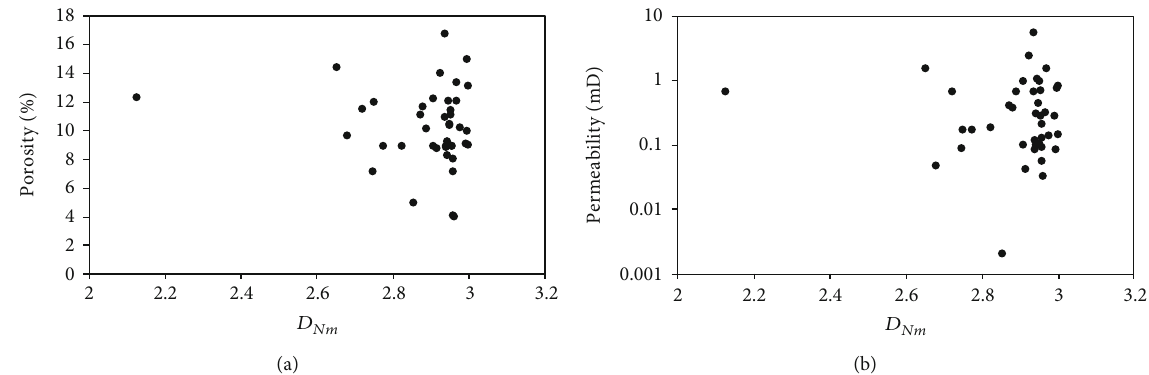
Figure 12: The cross-plots between modi fi ed fractal parameters from NMR tests and petrophysical properties: (a) the cross-plots between and porosity; (b) the cross-plots between D D Nm